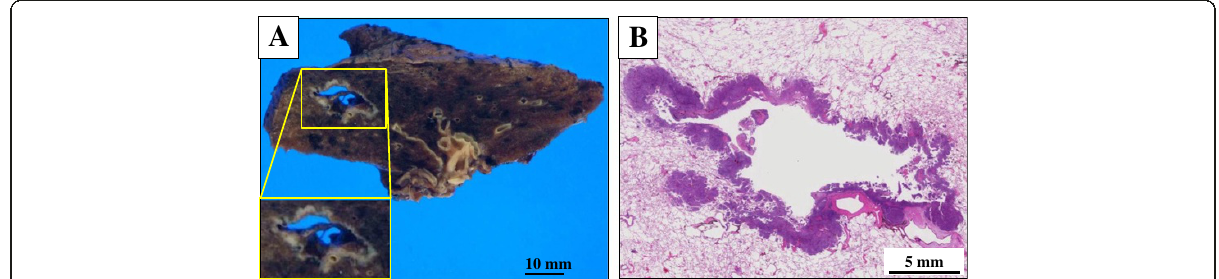
Figure 2 Gross and microscopic examination of the resected specimen. ( A ) On gross examination, the cut surface revealed a centrally cavity-formed, relatively poorly-demarcated, and solid firm mass, measuring 35 x 27 x 25 mm, which looked from grayish to whitish in color, partially adjacent to the bronchiole (lower side, inset). This central cavity measured approximately 30 x 10 mm, but filled with no necrobiotic materials. Bar = 10 mm. ( B ) A scanning magnification of it (H&E stains) showed that the cancer components were surrounded by the cavity and irregularly grew up along the asymmetrically thickened but relatively thin cavity wall, together with extension to the peripheral alveolar wall in a sheet-like fashion (lt. side). This tumor lesion was partly adjacent to the bronchiolo-vascular bundle (rt. lower side). There were no carcinoma in situ components in our case. Bar = 5 mm.